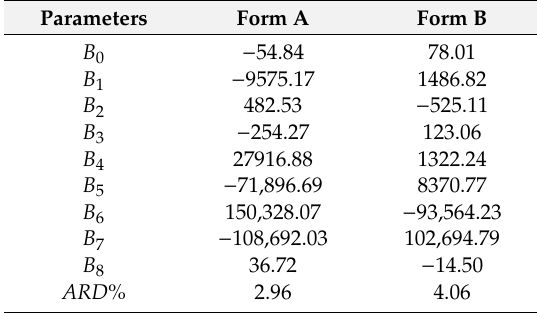
Table 6. Parameters of modified Jouyban–Acree model for ethyl acetate + toluene